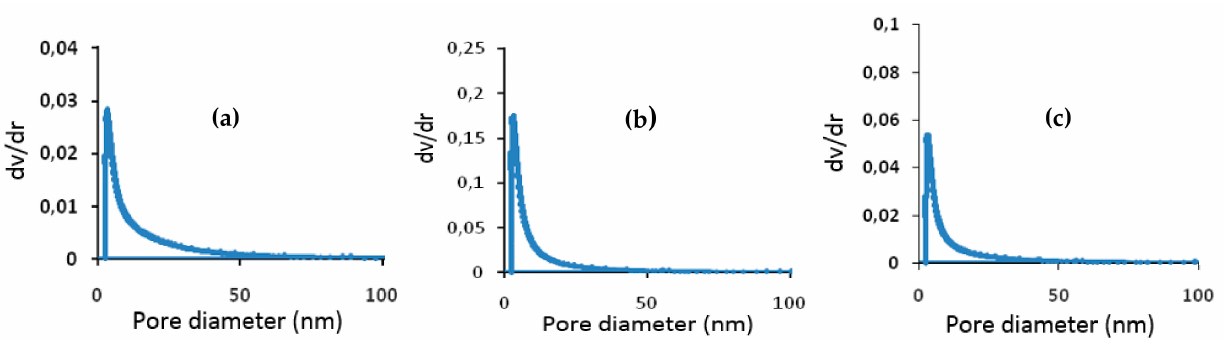
Figure 6. EDX mapping images representing the distributions of F and C (elements of PTFE polymer) and O, Al, and Si (elements of the clay matter) in the A50 membrane.